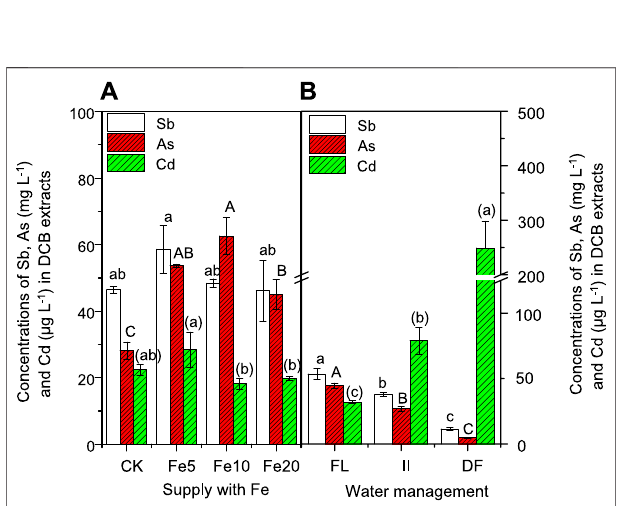
FIGURE 3 | Effects of FeCl 3 and water management on the concentrations of Sb, As, and Cd in the iron/manganese plaques. Bars are means and standard deviations for three replications. Different lowercase letters, capital letters, and parenthesized letters denote signi fi cant differences(at p ≤ 0.05)forSb,As,andCdconcentrationsintheDCBextracts among different treatments, respectively.